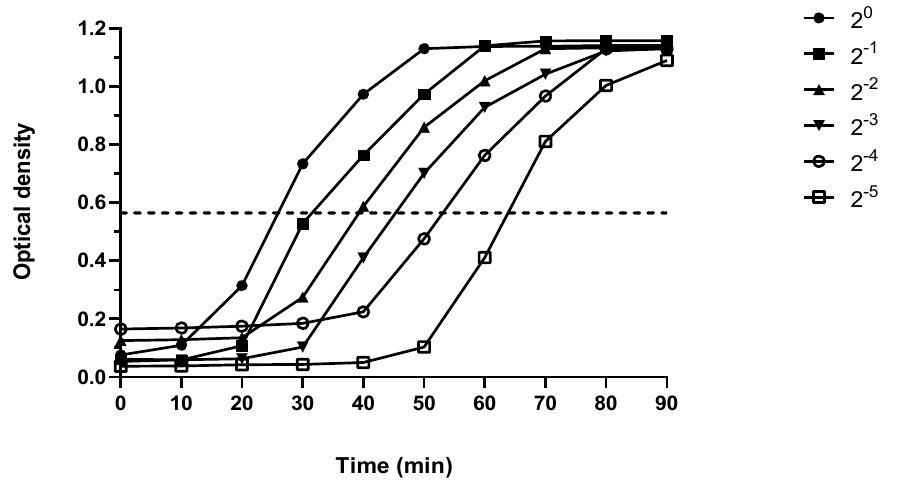
Figure 8. Kinetics of the absorption changes observed at a wavelength of 650 nm to determine the midpoint of the sigmoidal curve as marked by the dotted line (=OD 0.57).